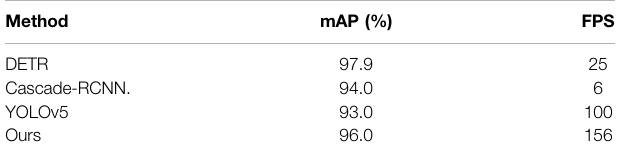
TABLE 7 | Different performances of detection